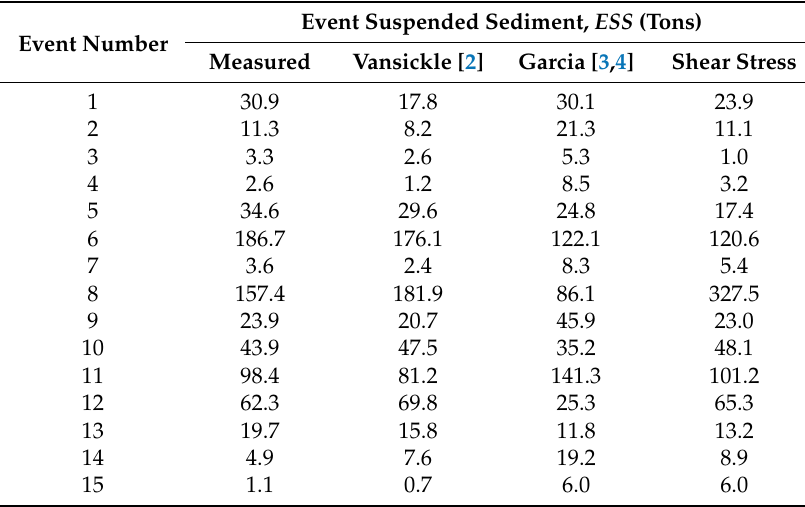
Table 3. Event suspended sediment, ESS